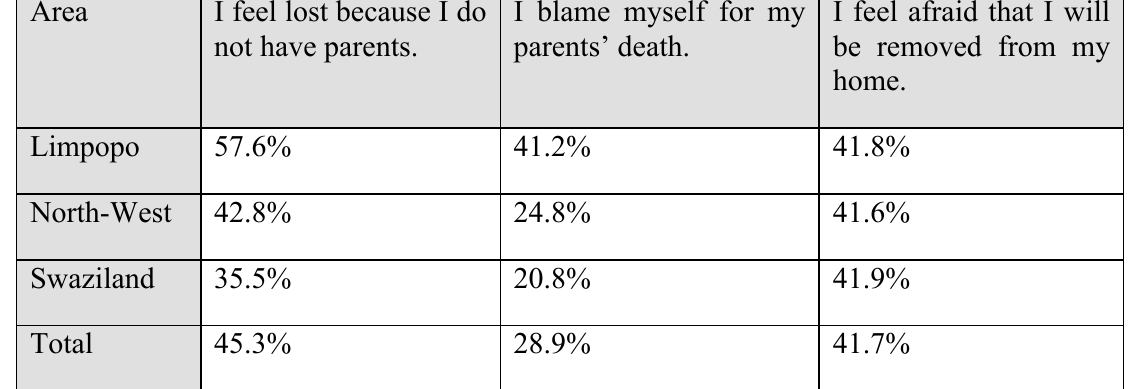
Table 4. Responses on how orphans experience their own situation regarding the death of their parents